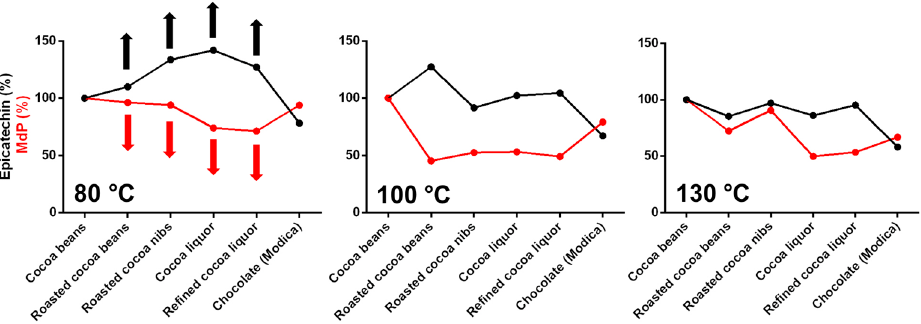
Figure 7. Comparison between the percentage of Epicatechin content (%) and mDP (%). Values have been normalized (100%) for the values of the relative cocoa bean sample.